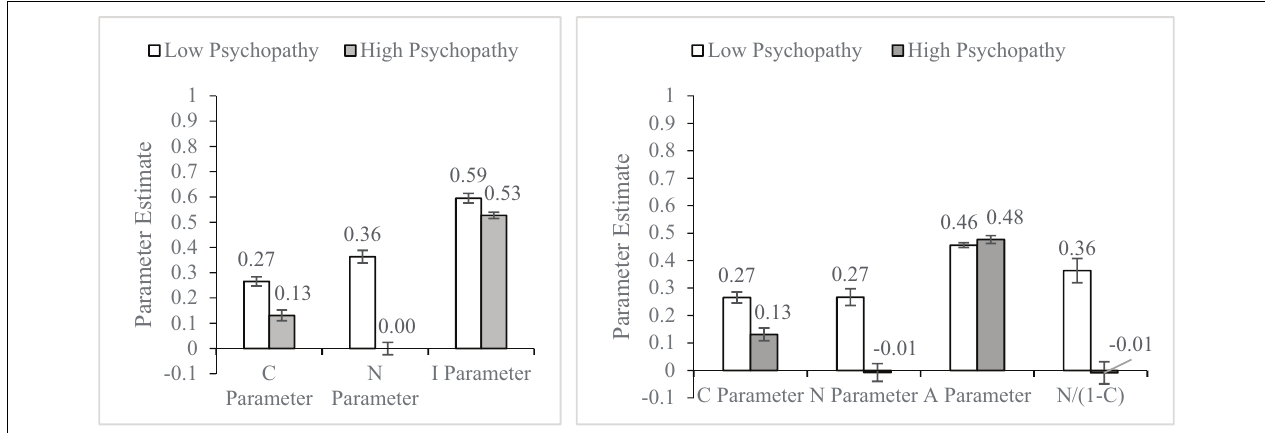
FIGURE A6 | Results of Study 4b by Gawronski et al. (2017) obtained from the CNI model (left) and CAN algorithm (right) . Error bars represent ± 1 SE.